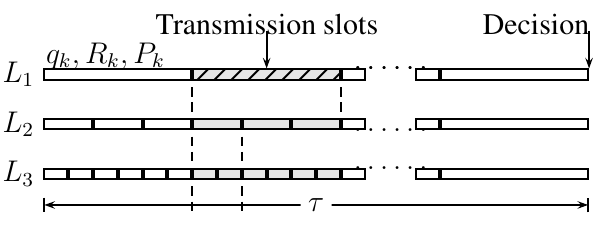
Figure 5. Detection cycle for the tree